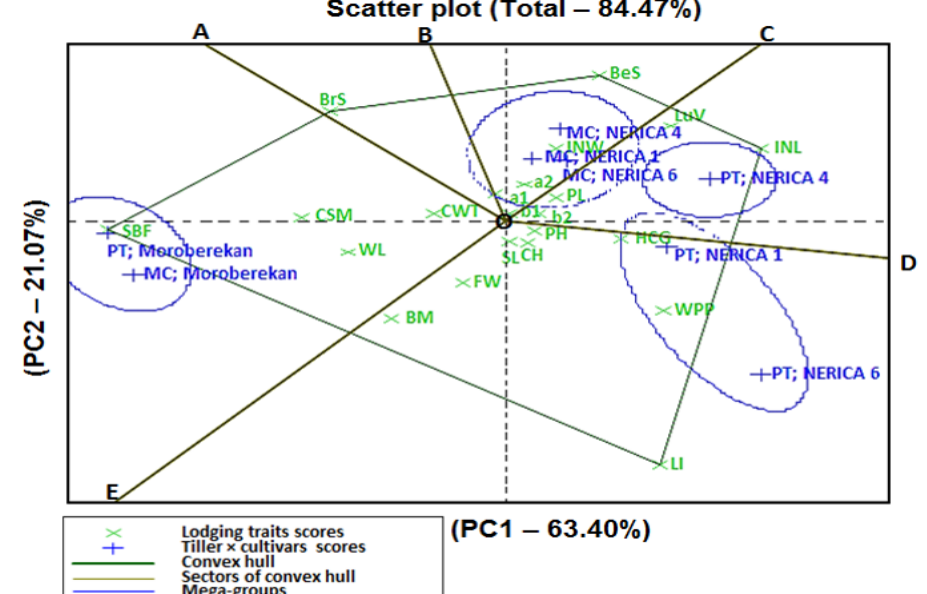
Figure 2: Principal component analysis biplot of tiller × cultivar by traits interaction of upland rice cultivars under nitrogen fertilizer rates.